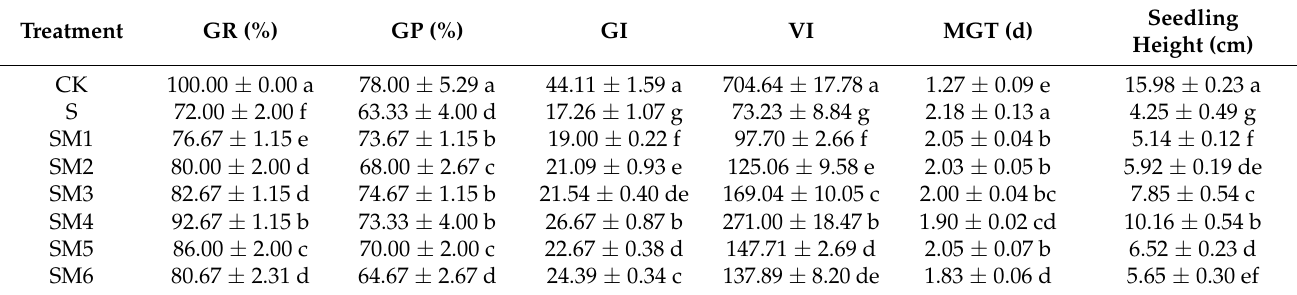
Table 1. Effect of different treatments on the wheat seed germination and seedling